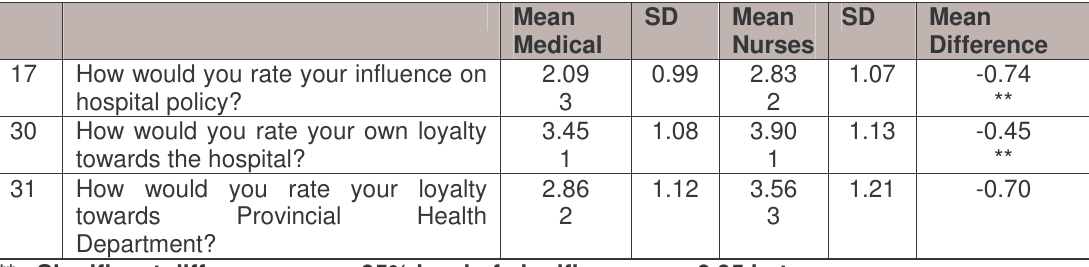
Table 5: Organisational citizenship (Average mean 3.11 )